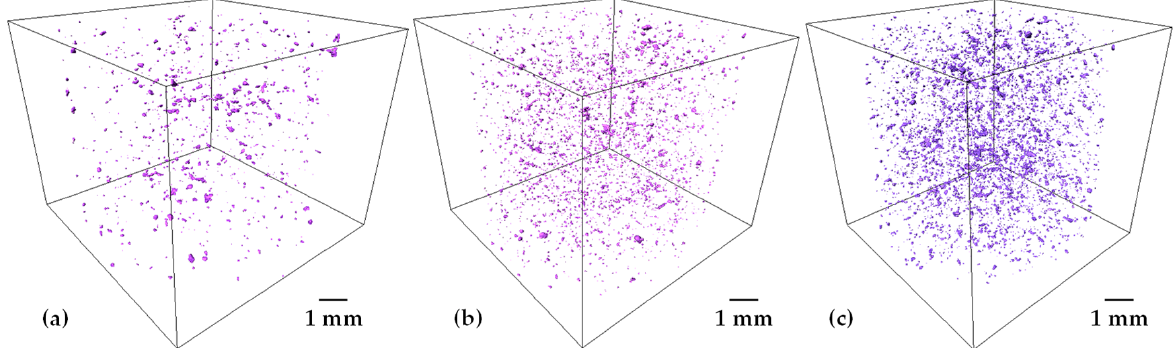
Figure 8. 3D rendering of the remaining Ta particles after sintering for samples containing 30 vol.% of salt particles, ( a ) Ti20Ta; ( b ) Ti25Ta; and ( c ) Ti30Ta.